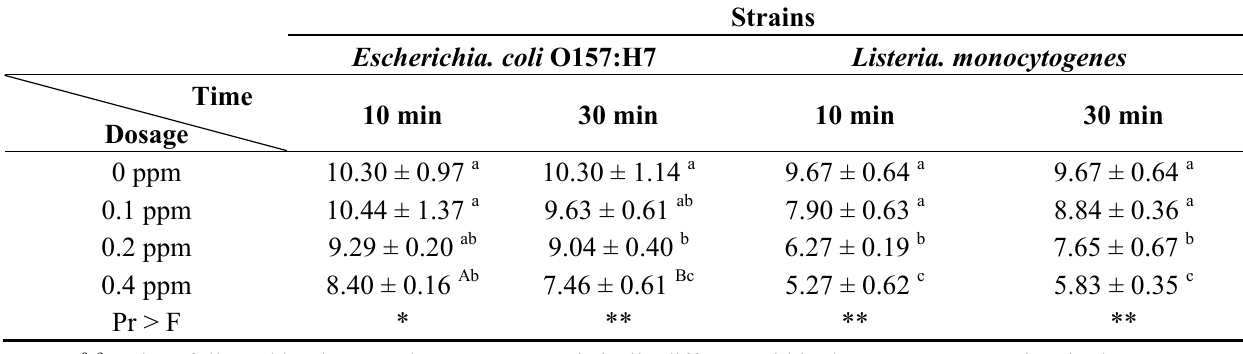
Table 1. Mean (standard deviation) bacterial counts in log cfu/mL of E. coli O157:H7 and L. monocytogenes in ozonated water at concentrations of 0.1, 0.2, and 0.4 ppm at 10 and 30 min exposure time.